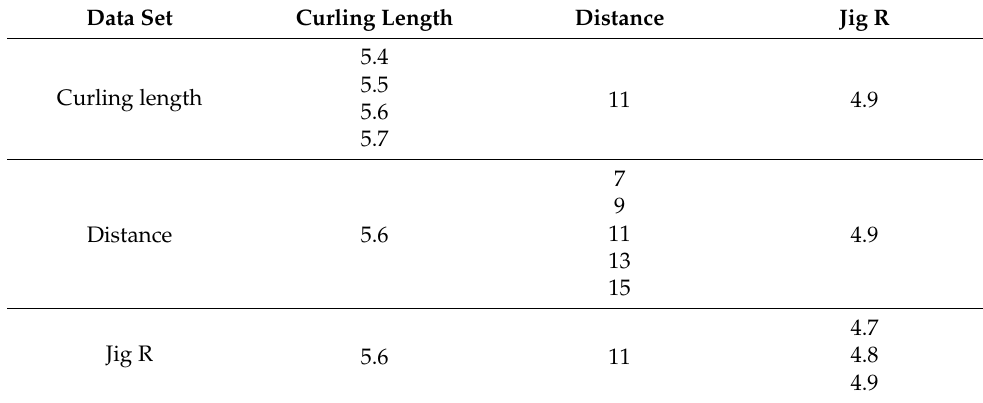
Table 4. Test Table 4. Test dataset.